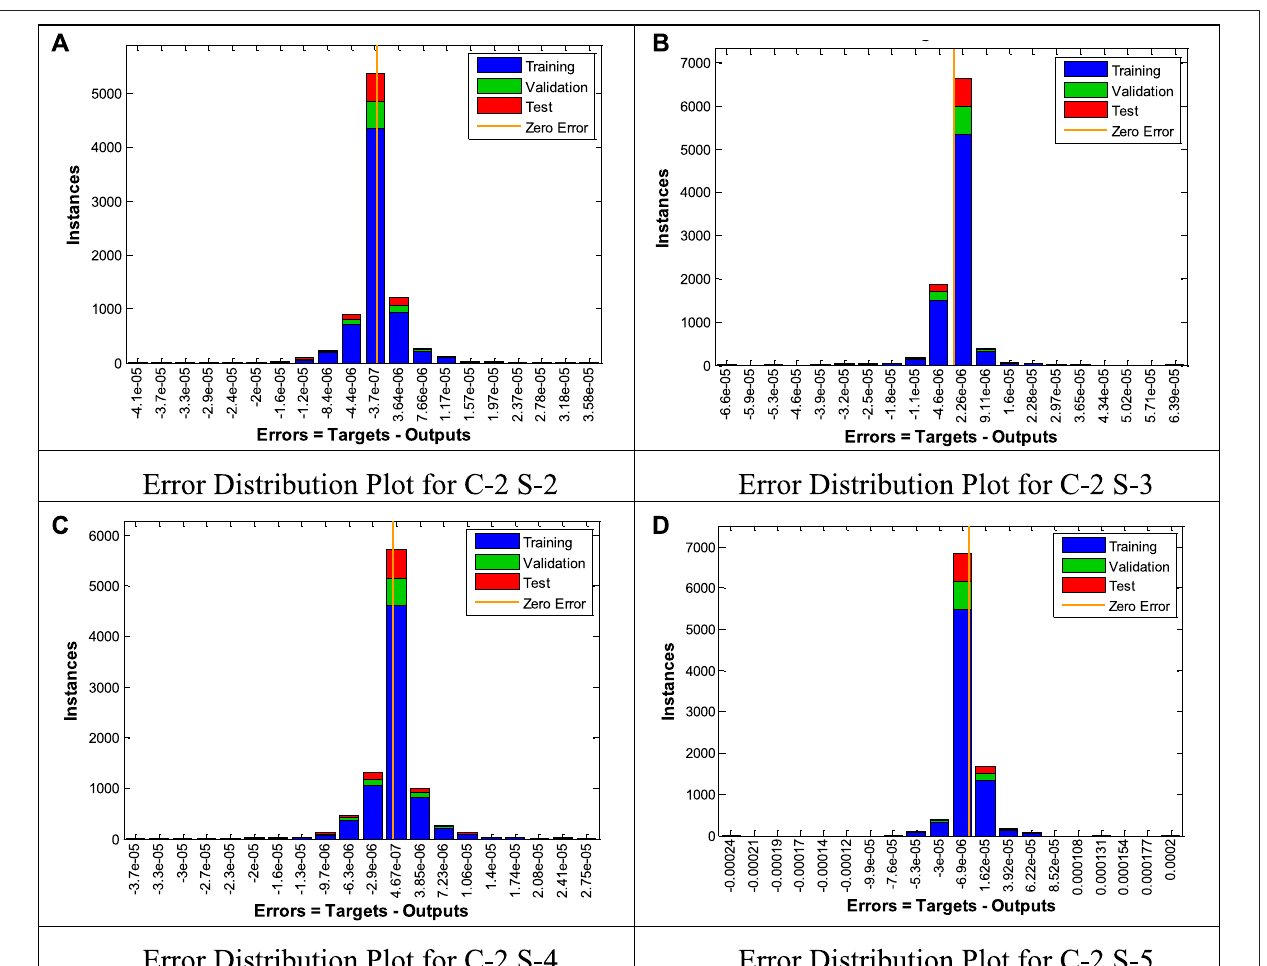
FIGURE 9 | Error distribution plots of second cases of all